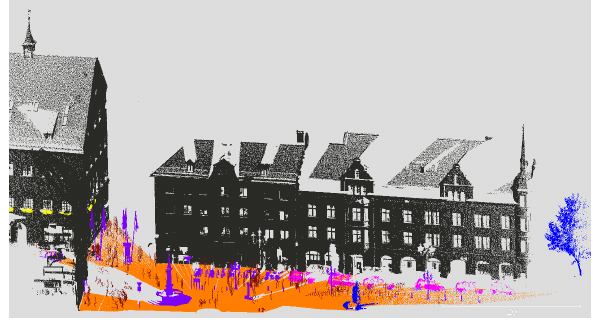
Figure 1: Example point cloud of the benchmark dataset, where colours indicate class